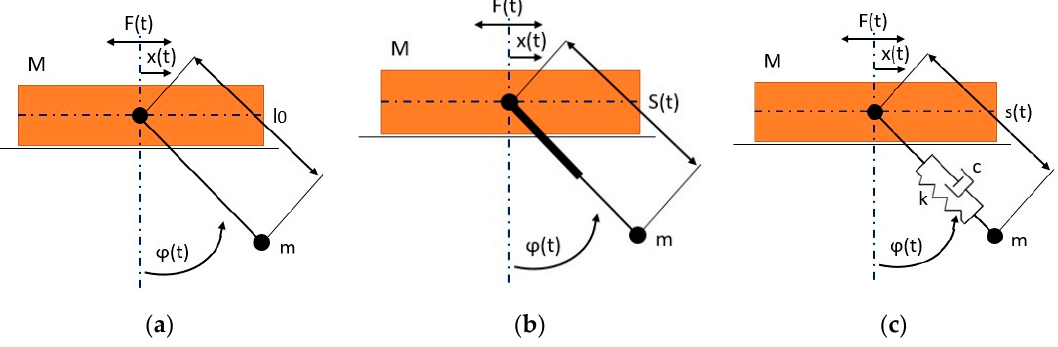
Figure 1. The analyzed systems: ( a ) rigid pendulum, ( b ) first parametric mutation, ( c ) second parametric mutation in an elastic form